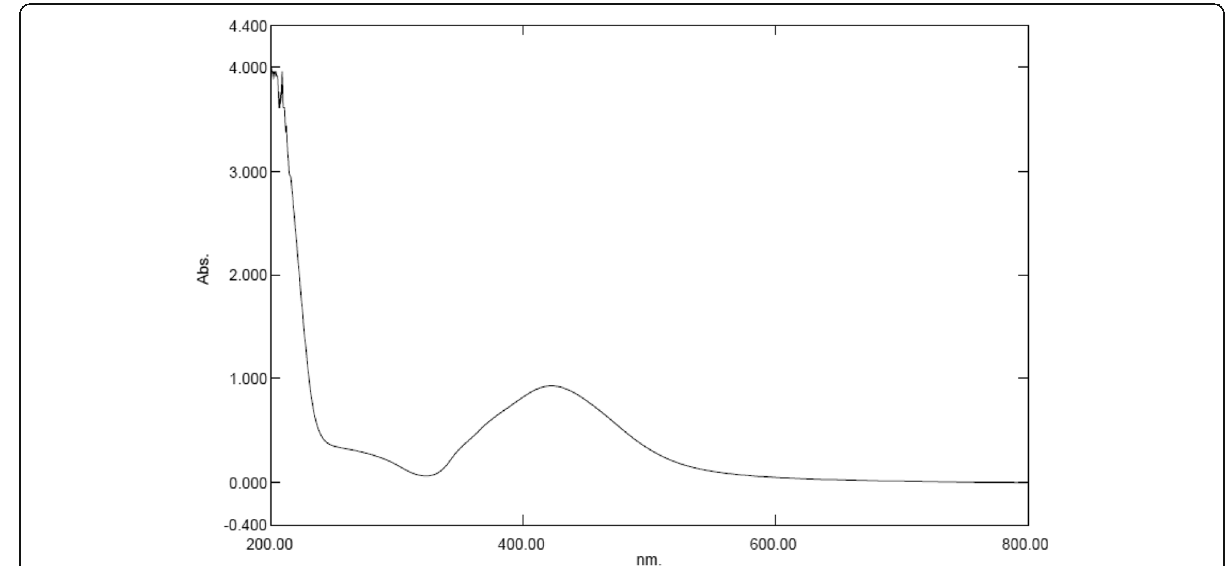
Fig. 1 UV Visible spectrum of chemically synthesized silver